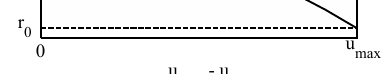
Figure 3: Controller